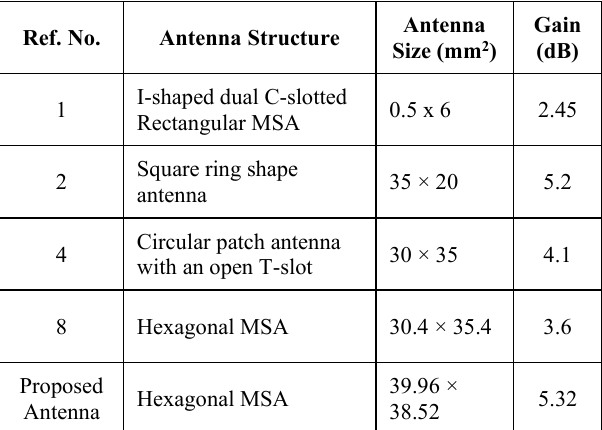
Table 2. Comparison with Literature